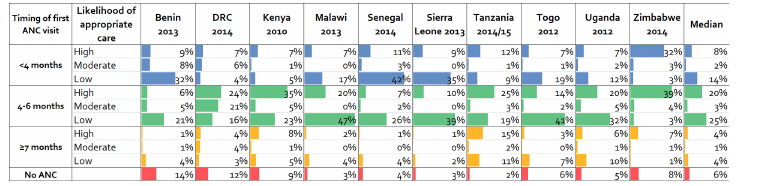
Fig 2. Likelihood of appropriate care for antenatal syphilis detection and treatment in 10 sub-Saharan African countries, 2010–2015. ANC: antenatal care. DRC: Democratic Republic of Congo. LAC: likelihood of appropriate